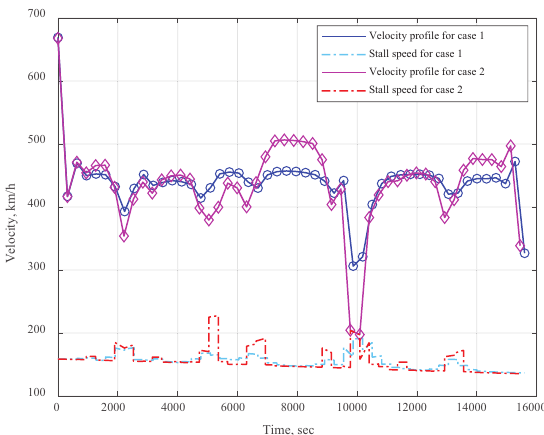
Figure 10. Optimal bank angle profiles for two simulations with 50 stages in scenario